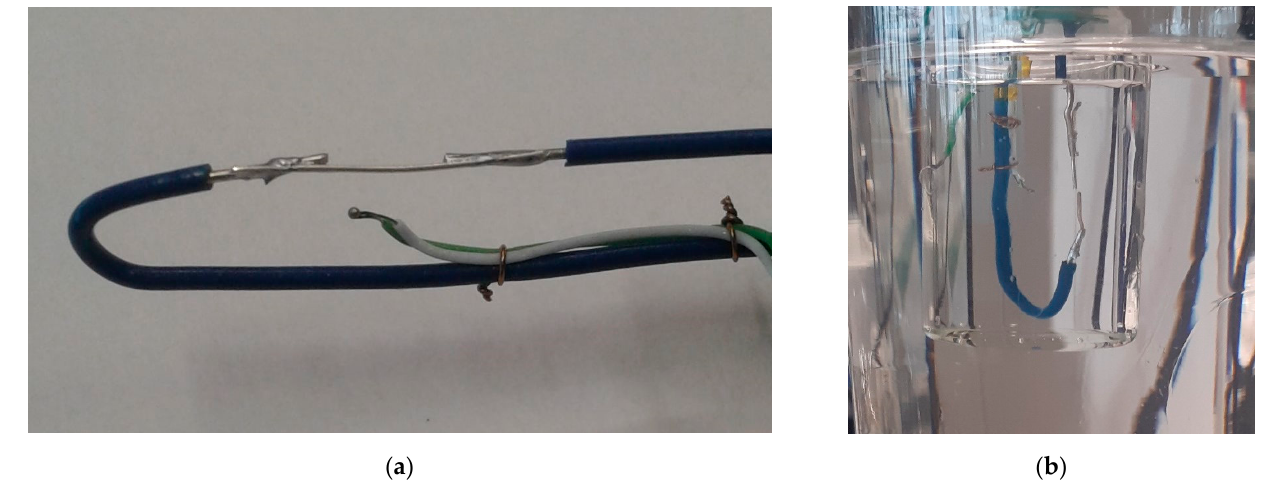
Figure 3. Configuration 2: ( a ) electrode assembly before section of the central silver wire in two electrodes; ( b ) submerged in the 30 ml beaker.